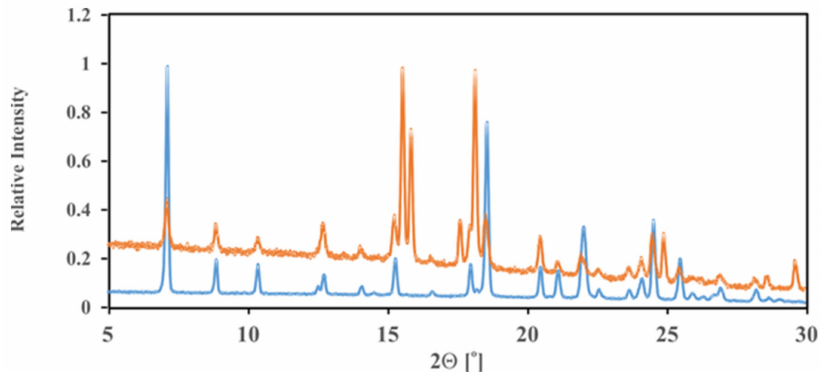
Figure 6. X-ray powder pattern recorded in Bragg Brentano geometry with a Cu K α ( λ = 1.5425 Å) source for compounds ( 1 ) (blue) and ( 3 ) (orange) and at room temperature.